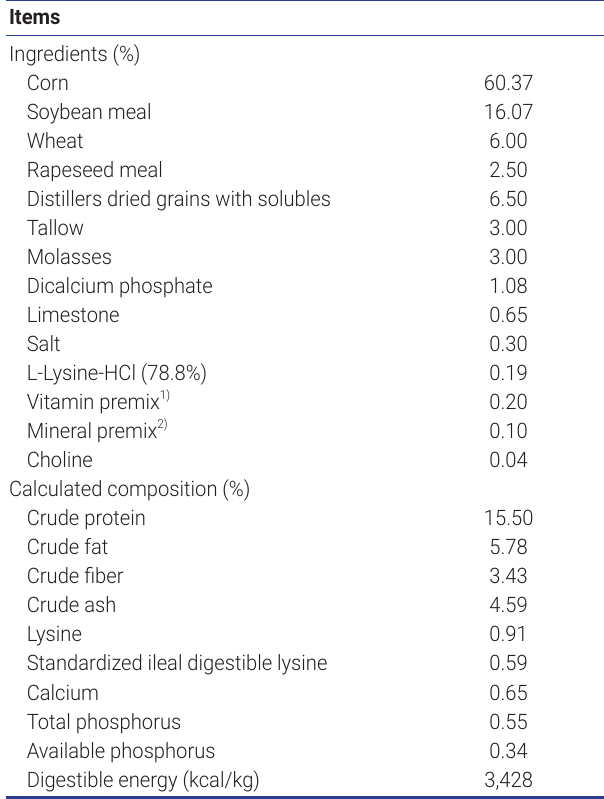
Table 1. Composition of experimental diets (as-fed